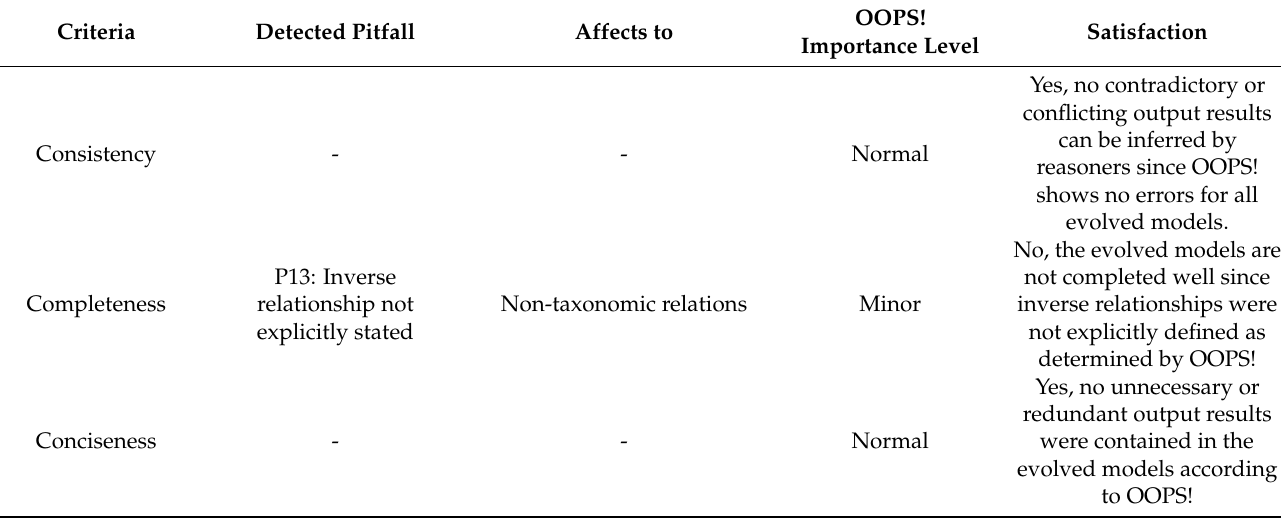
Table 8. Pitfalls in evolved ontology-based models detected by OOPS!